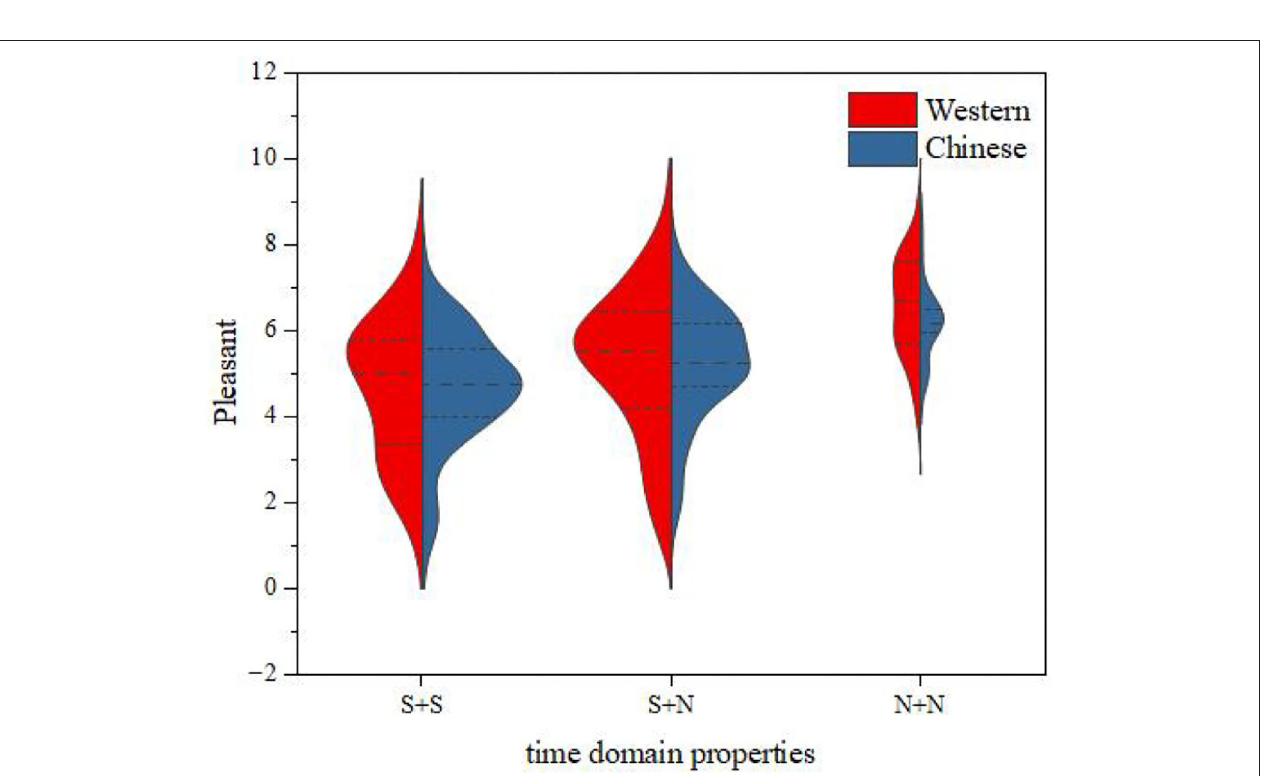
FIGURE 15 | Pleasantness comparisons between Western and Chinese